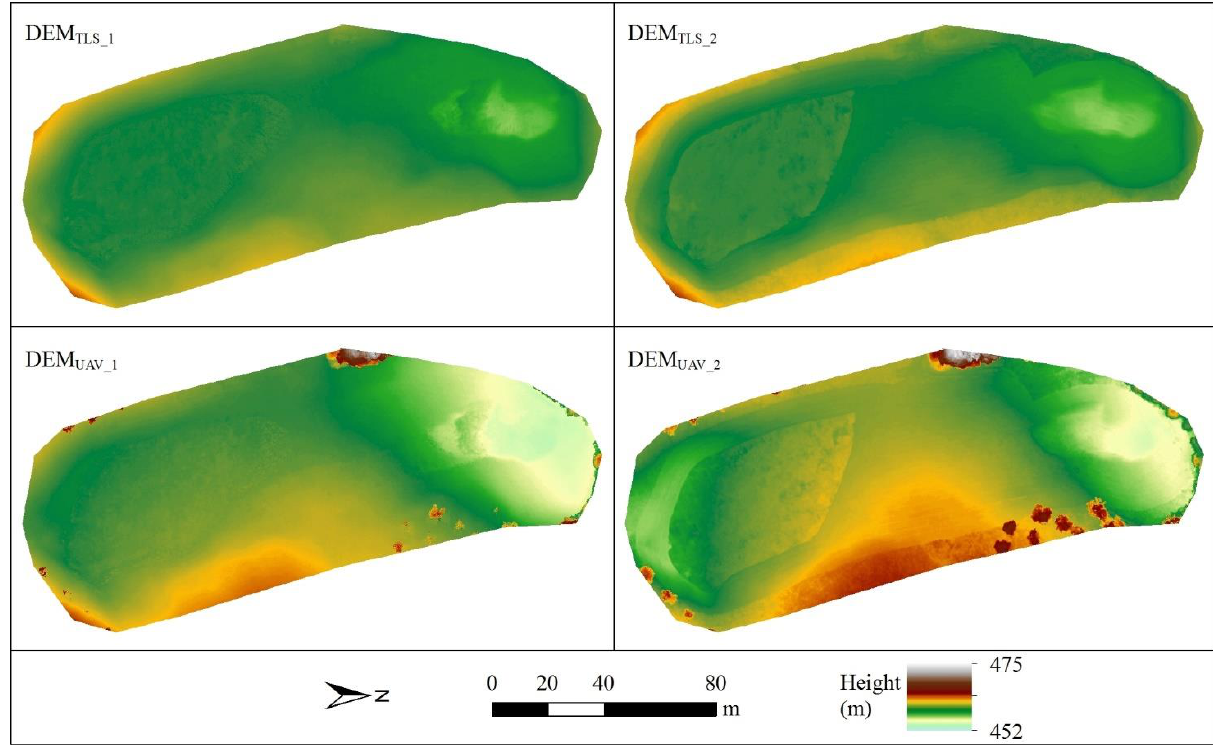
Figure 3. TLS-derived (top) and UAV-derived DEMs (bottom), each from October 2014 (left) and June 2015 (right).